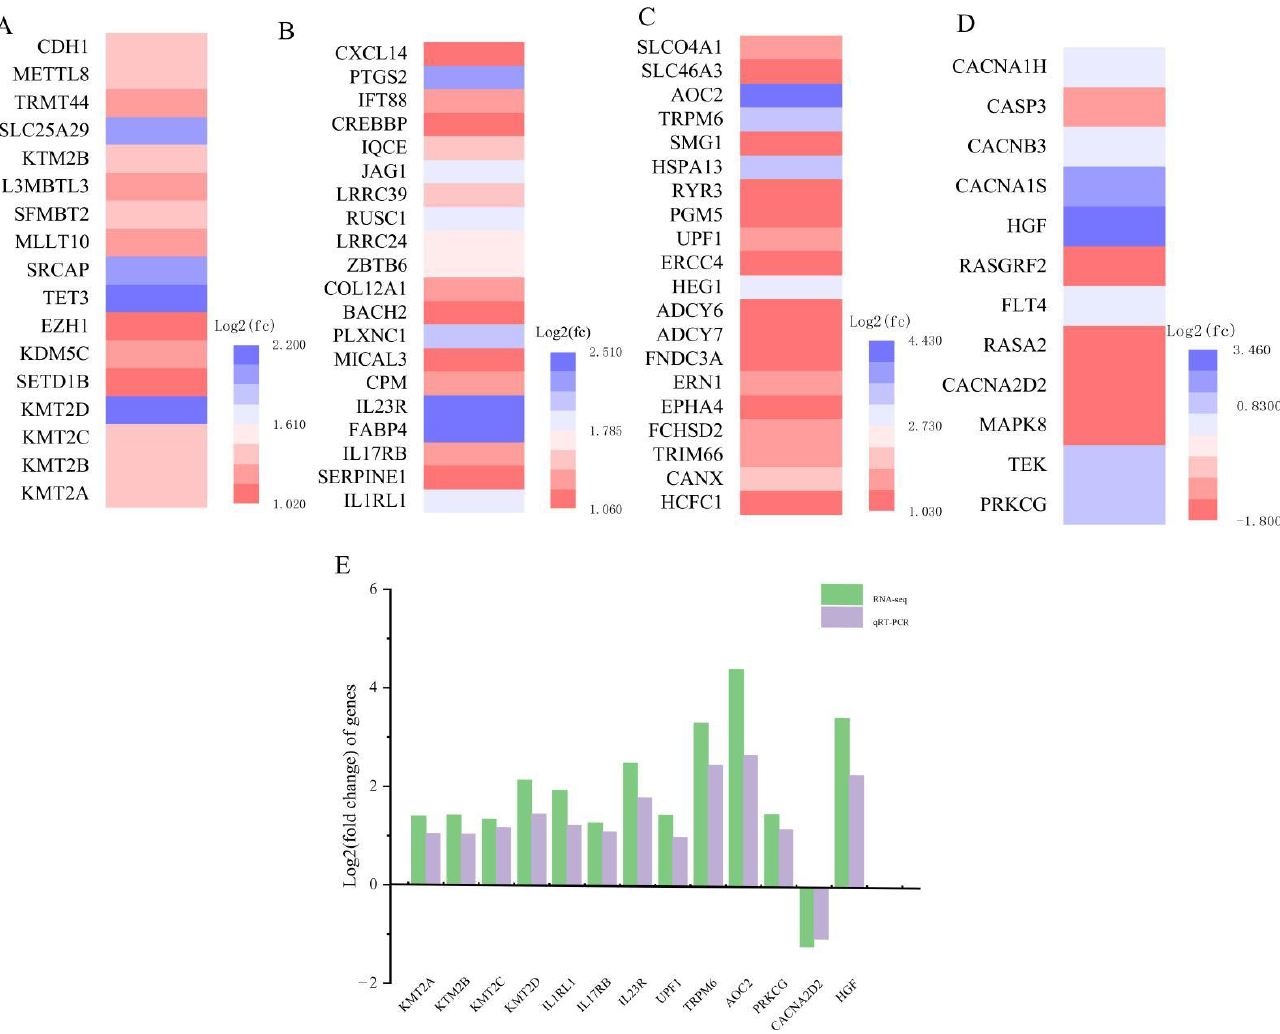
Figure 6. Forecast tendency of histone methyltransferase genes, oxidative stress, inflammatory, and MAPK signaling pathways in the pig spleen ( n = 6/group): ( A ) histone methyltransferase genes; ( B ) oxidative stress; ( C ) inflammatory; ( D ) MAPK signaling pathways. ( E ) Comparison and analysis of RNA-Seq and qRT-PCR results.